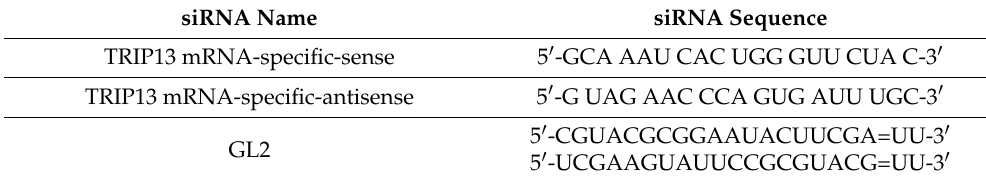
Table 3. A list of the siRNAs used in this